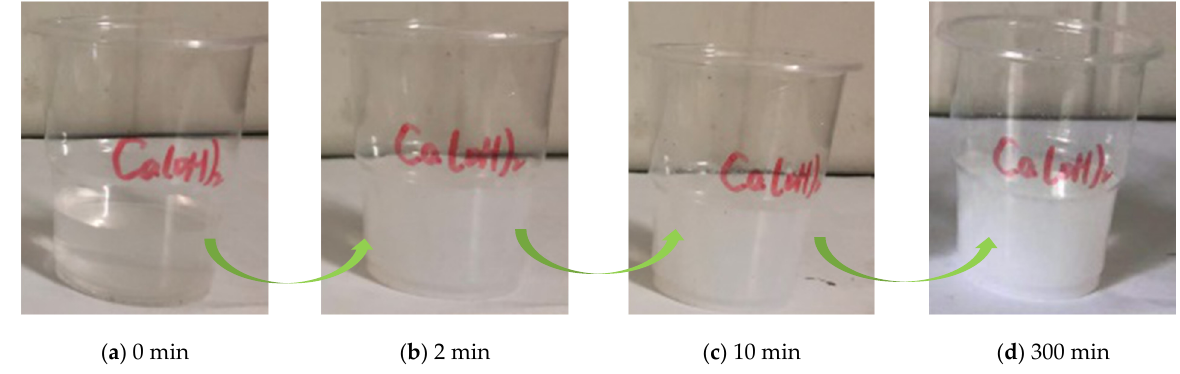
Figure 5. Precursor solution precipitation in alkaline solutions.